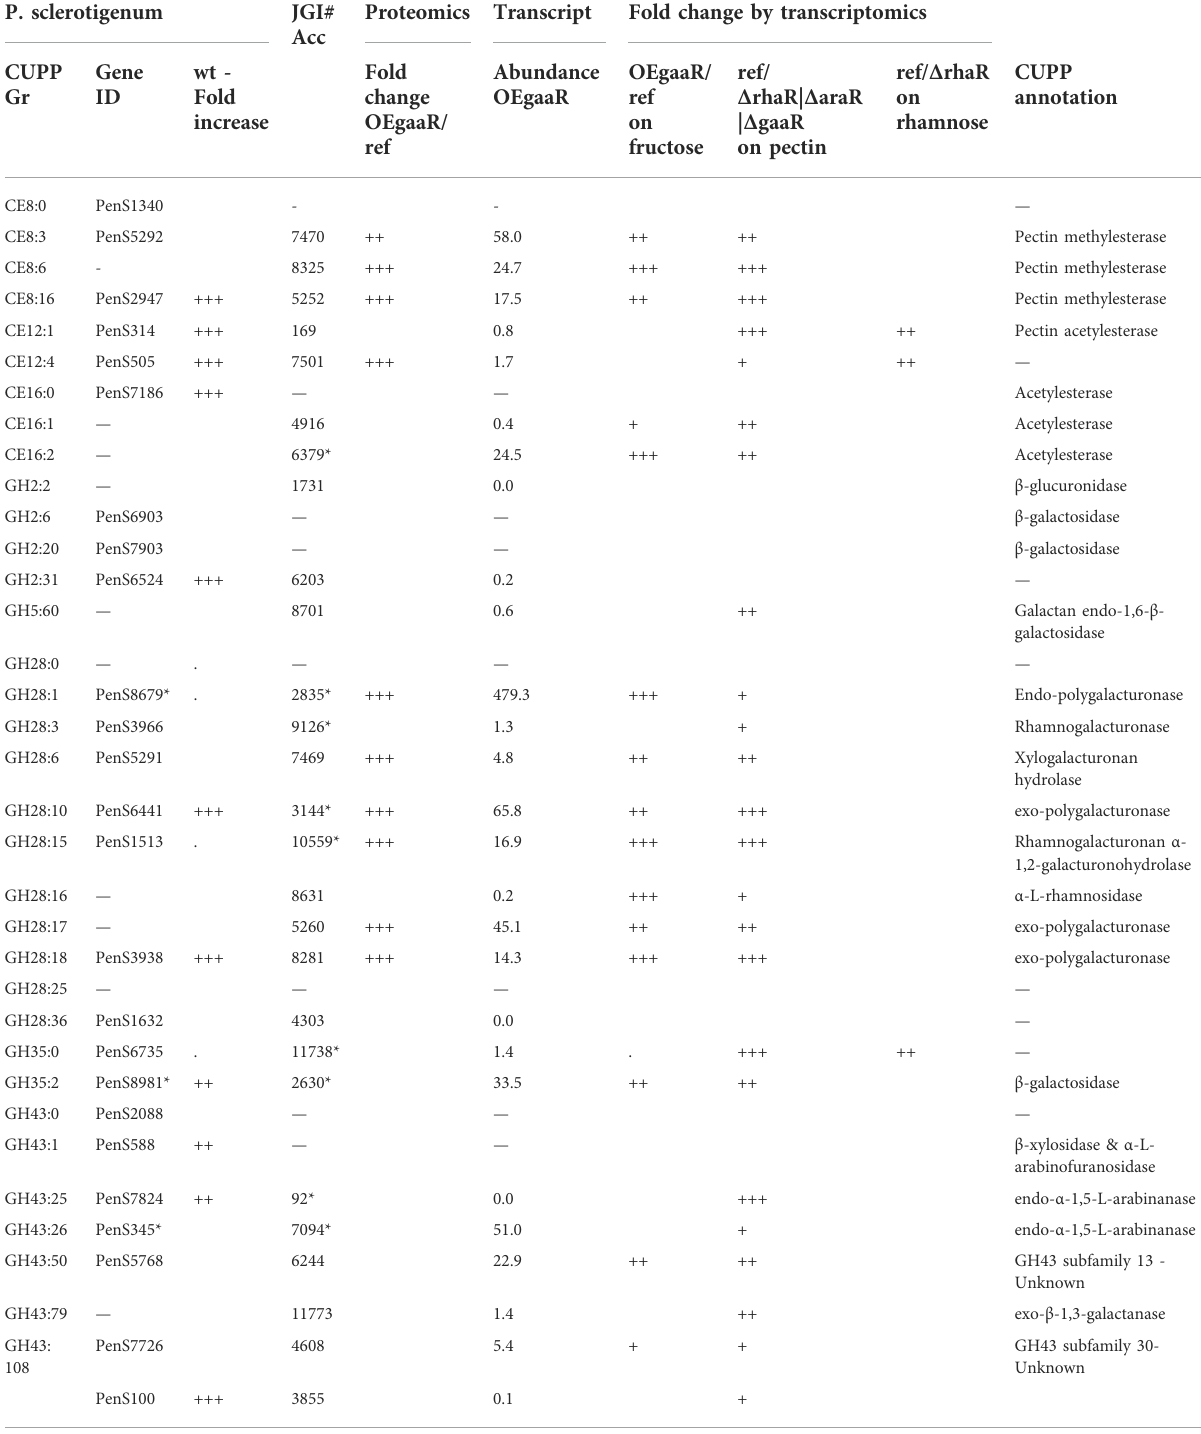
TABLE 6 Exo-proteome results of P. sclerotigenum and two studies of pectin-associated CAZymes found in A. niger strain NRRL3 with proteomics and transcriptomics data from various combinatory regulator knock-out studies (Kowalczyk et al., 2017) or regulator overexpression studies (Alazi et al., 2018). The CUPP groups and the accession number of at least one member of the group, if any. The asterisk indicates that multiple CAZymes are found in the respective CUPP group for the respective strain. A. niger strain NRRL3 proteomics & transcriptomics by regulatory alterations P.